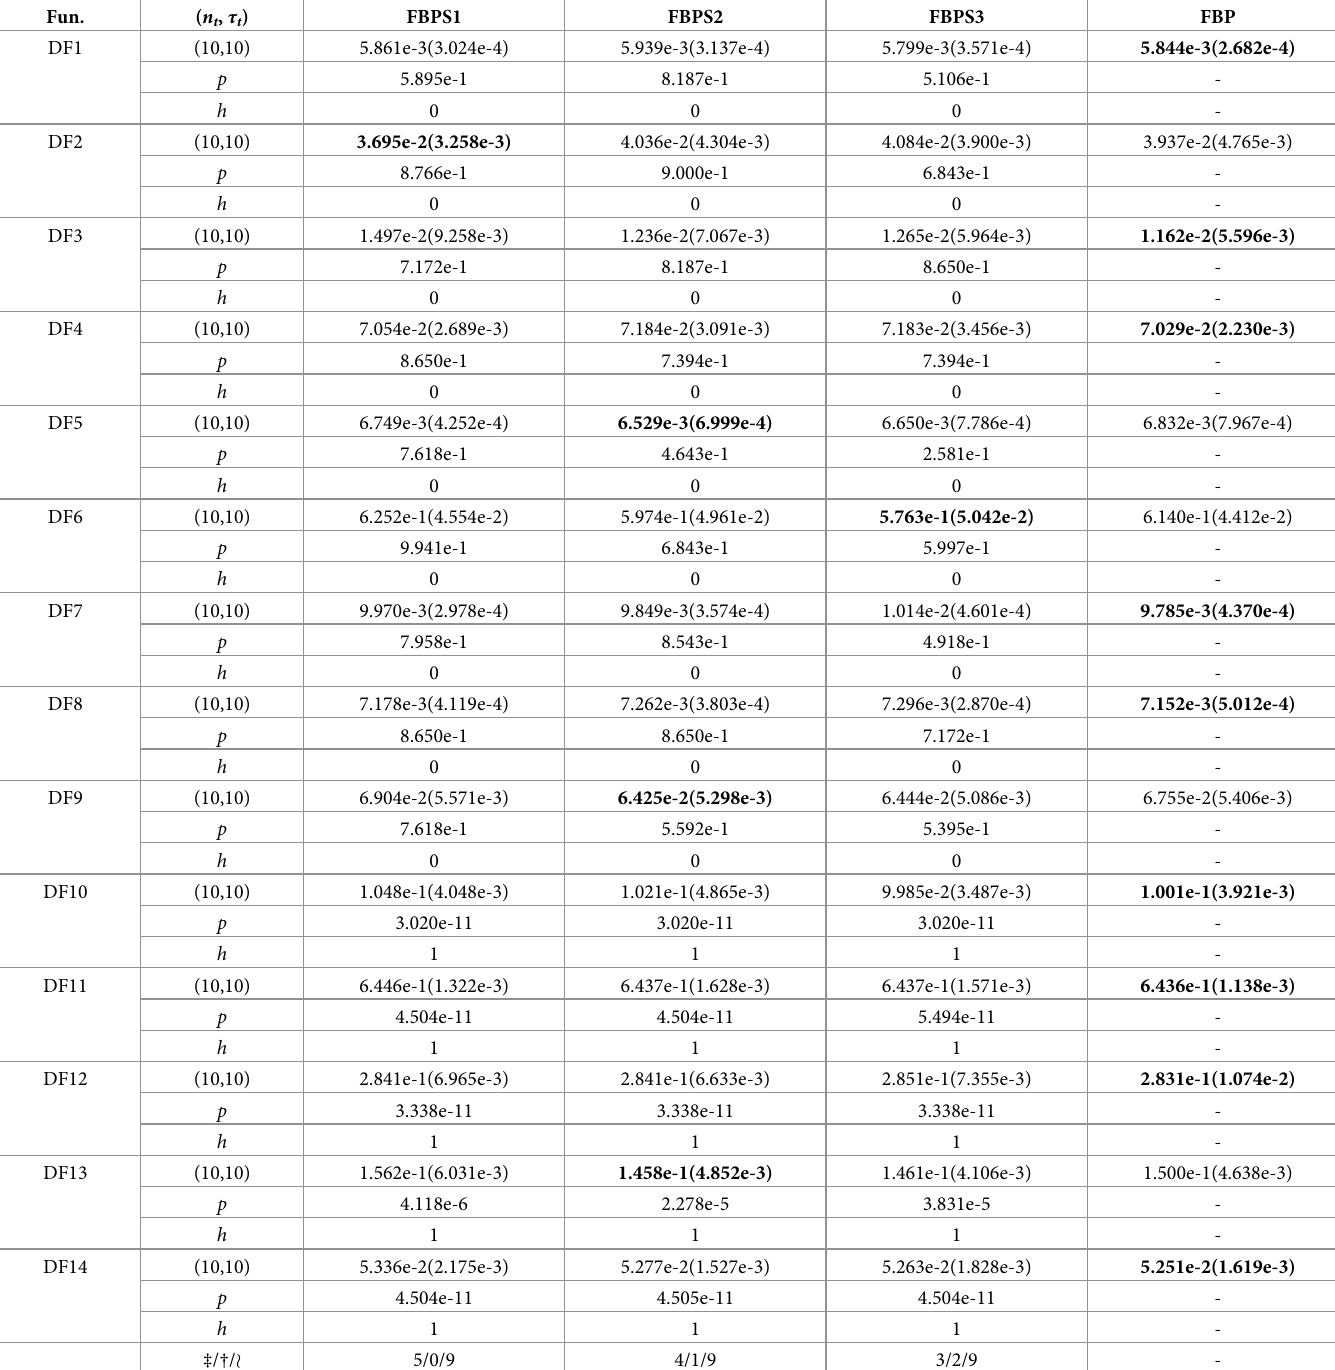
Table 14. Performance comparison of FBP variants on MIGD for ( n t , τ t ) = (10,10).